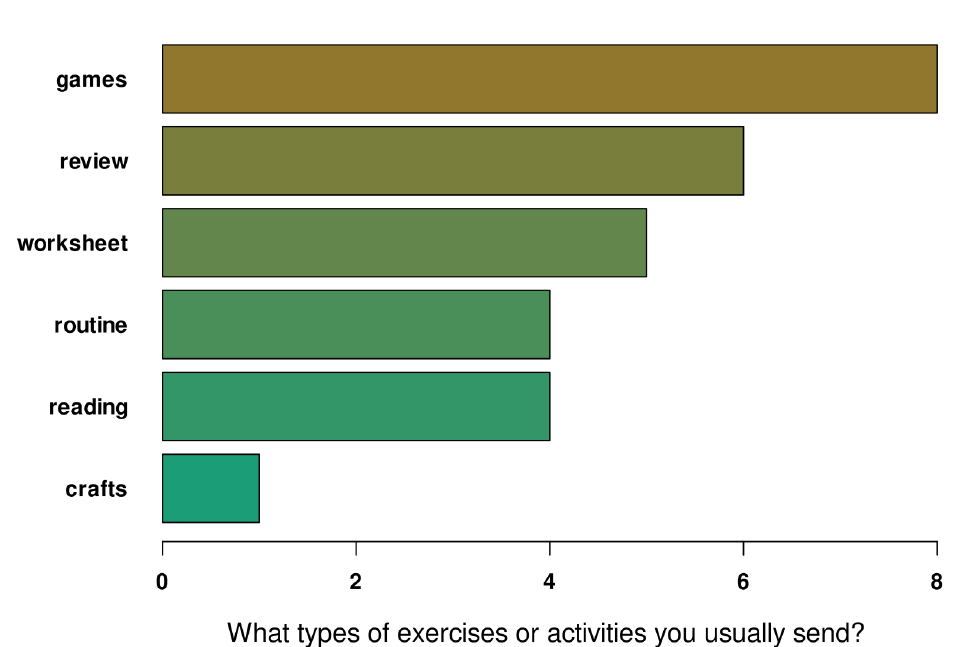
Figure 10. Most common type of activities or exercises sent home.